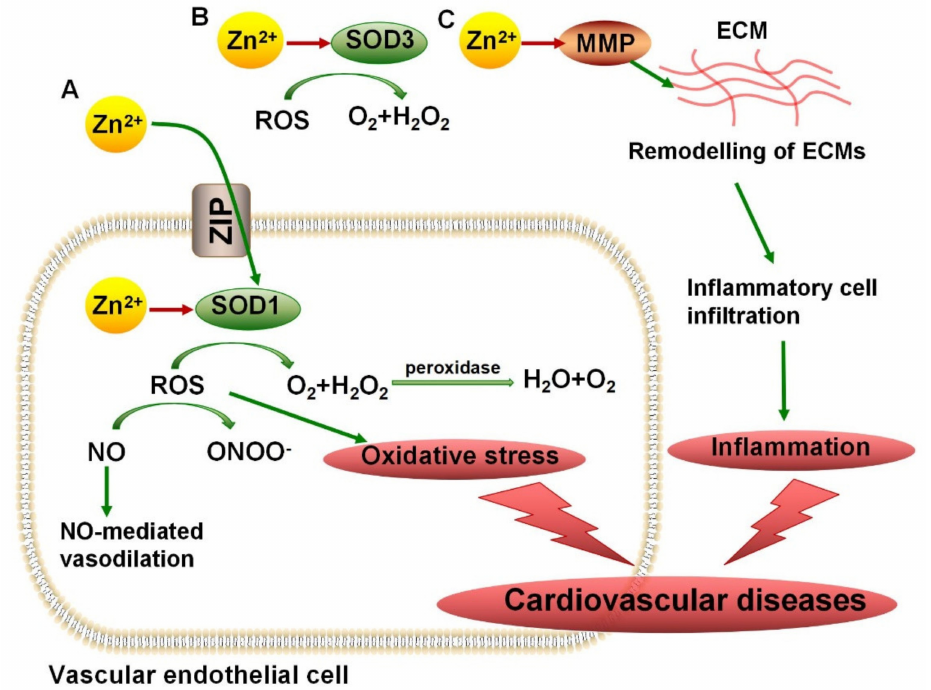
Figure 2. The protective and stimulative mechanism of Zn 2+ on cardiovascular diseases. ( A ) Zn 2+ enters cells via ZIP, binds with SOD1 to promote ROS breakdown and protects blood vessels from oxidative stress. ROS promotes the conversion of NO to ONOO − . NO is an important component responsible for vasodilation. SOD1 enhances the decomposition of ROS, and the reduced ROS leads to the reduction of NO conversion which facilitates NO-mediated vasodilation. ( B ) In the extracellular space, Zn 2+ can increase the activity of SOD3, thereby promoting the conversion of ROS and alleviating the damage of oxidative stress to blood vessels. ( C ) The combination of Zn 2+ with MMP can enhance the activity of enzymes, promoting the degradation of ECMs and the movement of inflammatory cells to the damaged site, ultimately leading to the damage of vessels due to inflammatory response. ZIP, Zrt- and Irt-like protein; SOD, superoxide dismutase; MMP, matrix metalloproteinase; ECM, extracellular matrix; ROS, reactive oxygen